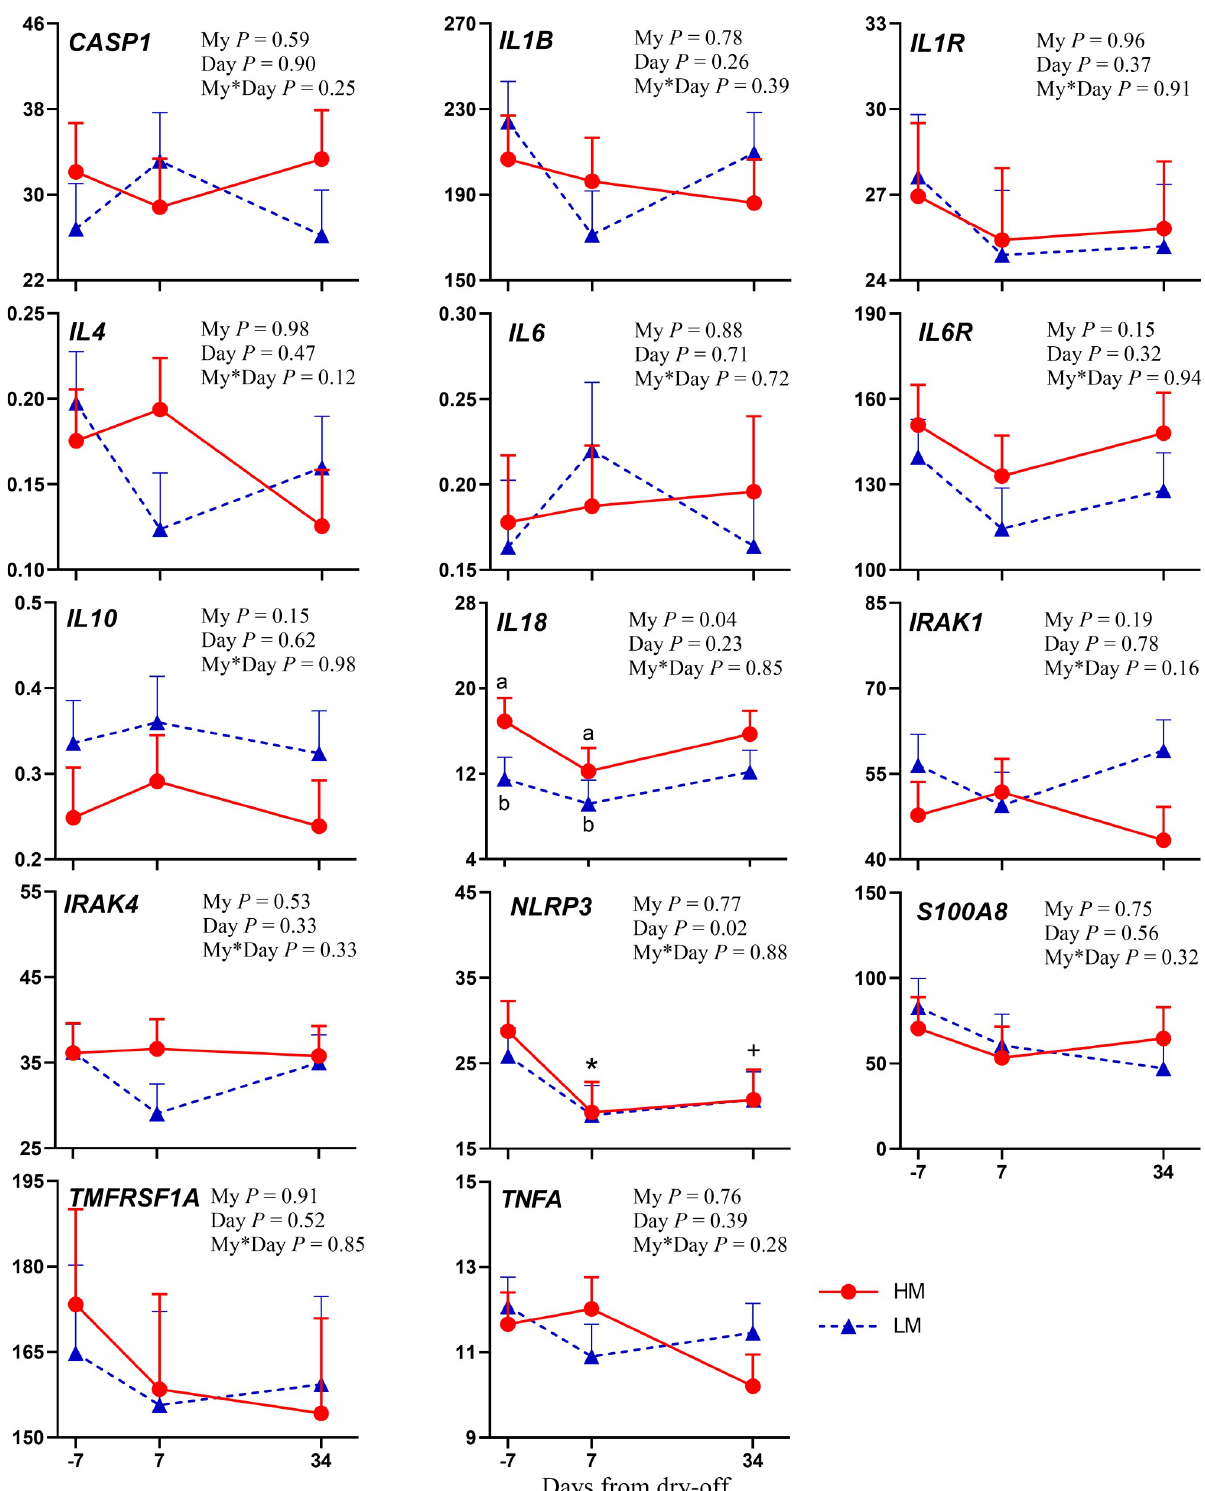
Fig 1. mRNA abundance of genes involved in the inflammatory cascade. Changes from -7 days from dry-off (DFD) to 34 DFD in dairy cows with high (HM; red line) or low (LM; blue line) milk yield at dry-off in mRNA abundance (mean ± SEM) for gene expression of genes involved in the inflammatory cascade: CASP1 (Caspase 1), IL1B (Interleukin 1 Beta), IL1R (Interleukin 1 Receptor), IL4 (Interleukin 4), IL6 (Interleukin 6), IL6R